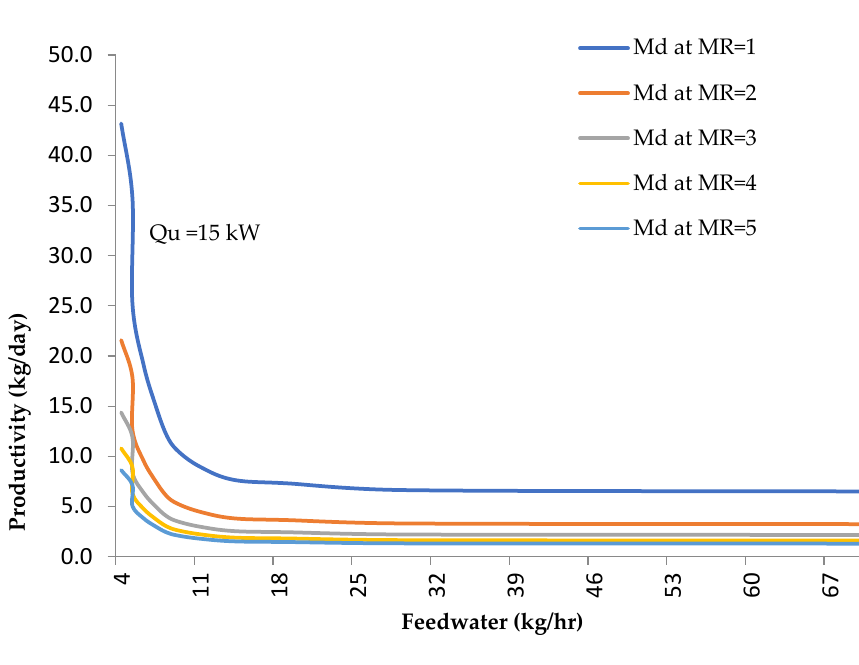
Figure 8. Effect of the feed water flow rate on the distillate production, Qu = 15 kW.